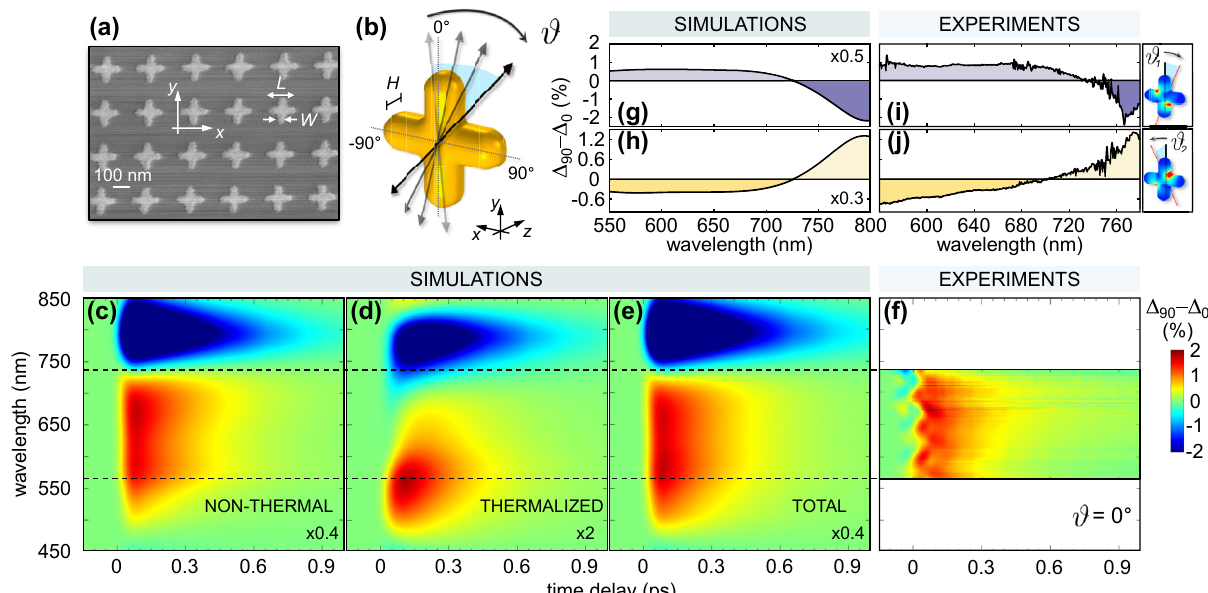
Figure 9: Ultrafast symmetry breaking for all-optical modulation and reconfiguration of light polarization. (a) SEM image of the metasurface. (b) Sketch of the light–matter interaction between the cross-shaped meta-atom and the linearly polarized light with varying polarization angle 𝜗 . (c–f) Simulated ultrafast photoinduced dichroism spectrum for pump polarization angle 𝜗 = 0 ◦ , disentangled in terms of the contributions arising from non-thermal carriers (c) thermalized carriers (d) together with the total effect (e) and the experimental signal (f) in the spectral range accessible by the measurement (fluence ∼ 400 μ J/cm 2 ). Adapted with permission from ref. [58]. Copyright 2020, Springer Nature. (g–j) Simulated (g, h) and experimental (i, j) spectra of the dichroism evaluated at 100 fs time delay for a pump polarization angle of 𝜗 permission from ref. [223]. Copyright 2022 Author(s), licensed under a CC-BY Creative Commons Attributions 4.0